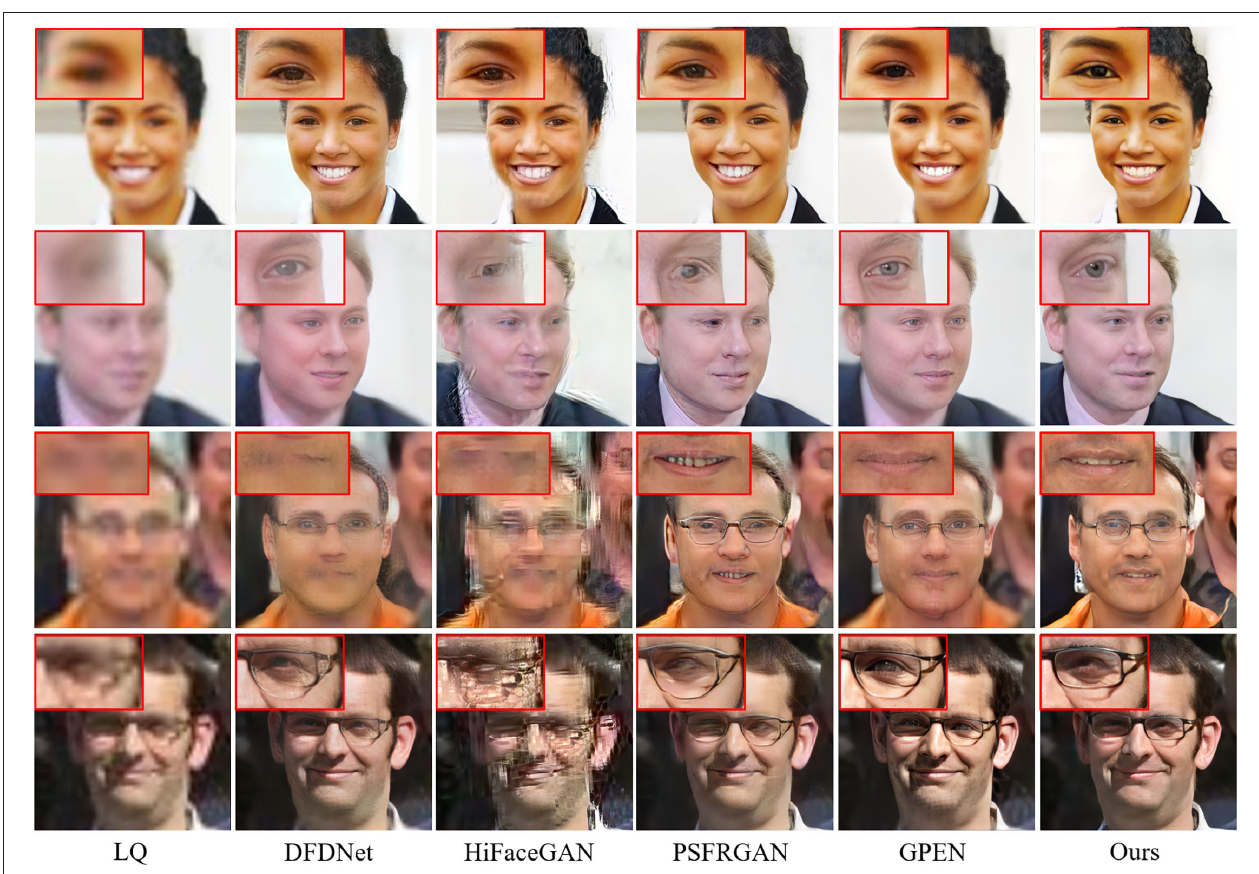
FIGURE 15 | Visual comparisons of competing methods with top performance on real-world LQ images (